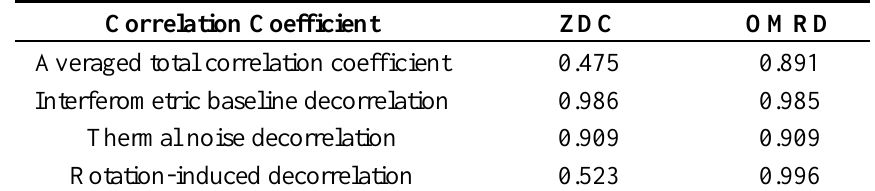
Figure 6. Coherence maps of the GEO InSAR pairs corresponding to two data acquisition methods: ( a ) ZDC data acquisition method; ( b ) optimal minimal rotational-induced decorrelation (OMRD) data acquisition method. Table 6. Sources of decorrelation of the GEO InSAR pairs corresponding to two data acquisition